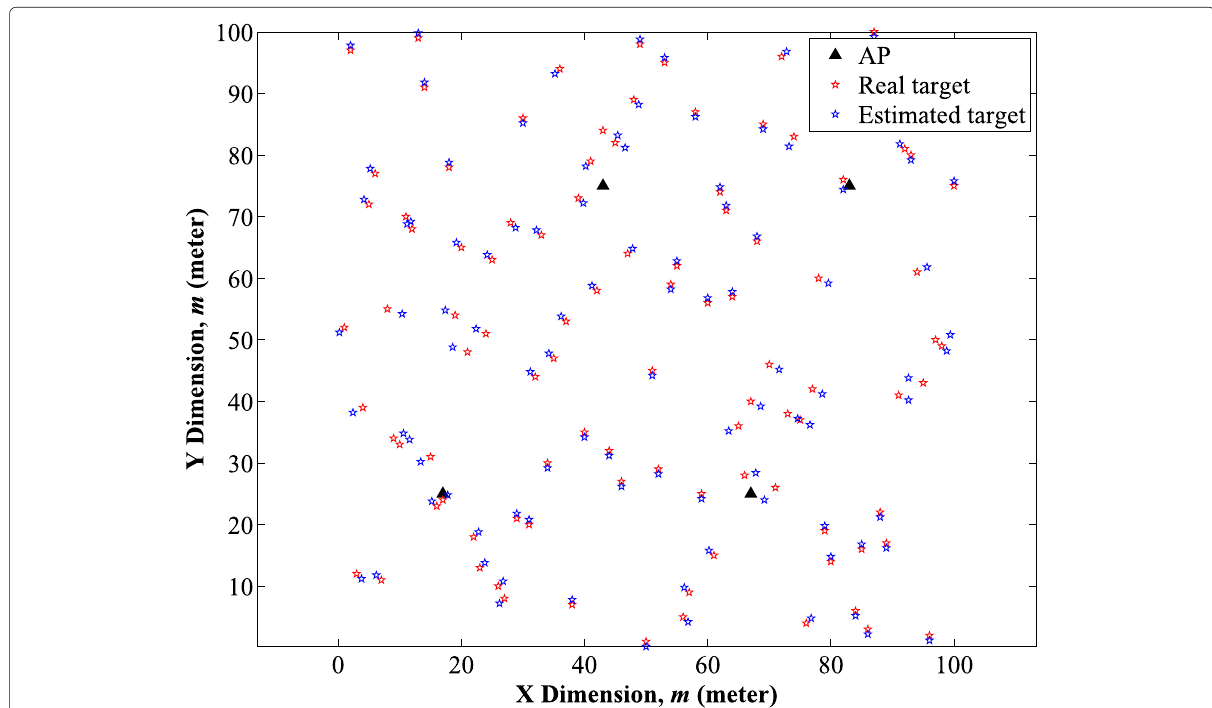
Fig. 12 Positioning result of the proposed RSSD-VRKNN algorithm. 100 positioning targets and 4 AP positions in area 100 m × 100